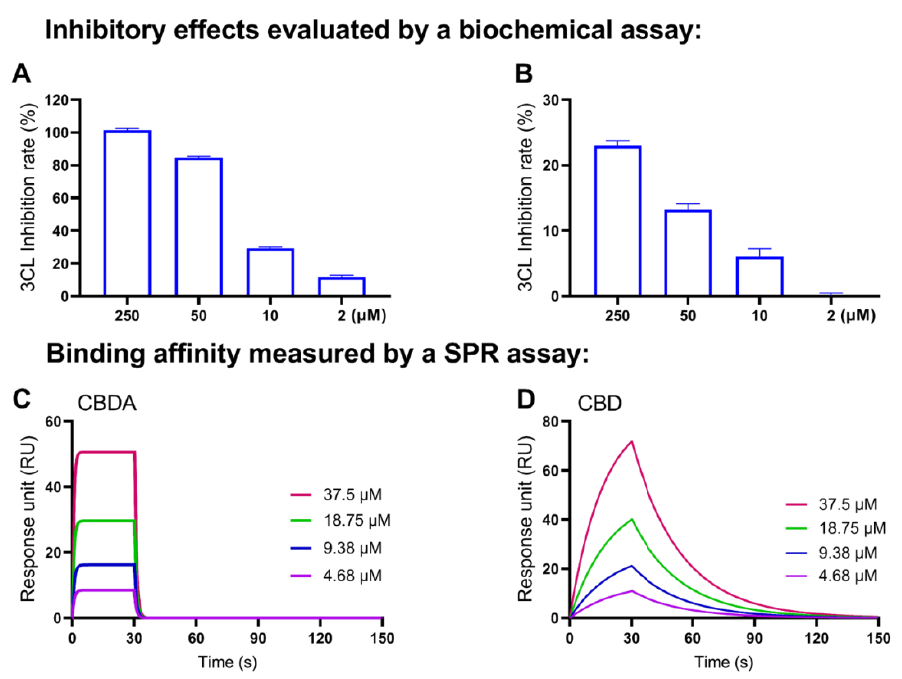
Figure 9. Concentration-dependent inhibitory effects of the CBD-type cannabinoids on the M pro activity (evaluated by a biochemical enzyme inhibition assay) and their binding capacity to the M pro protein (measured by the SPR assay). The IC 50 values of CBDA ( A ) and CBD ( B ) were calculated by data from a biochemical assay with the GraphPad Prism8. The binding affinities between CBDA or CBD and the M pro protein were determined by the SPR assay with a representative SPR sensorgram of the binding between CBdA ( C ) or CBD ( D ) and the M pro protein. Table 4. M pro protein binding parameters ( K a, K d, and K D ) of CBDA and CBD obtained from the SPR experiments.